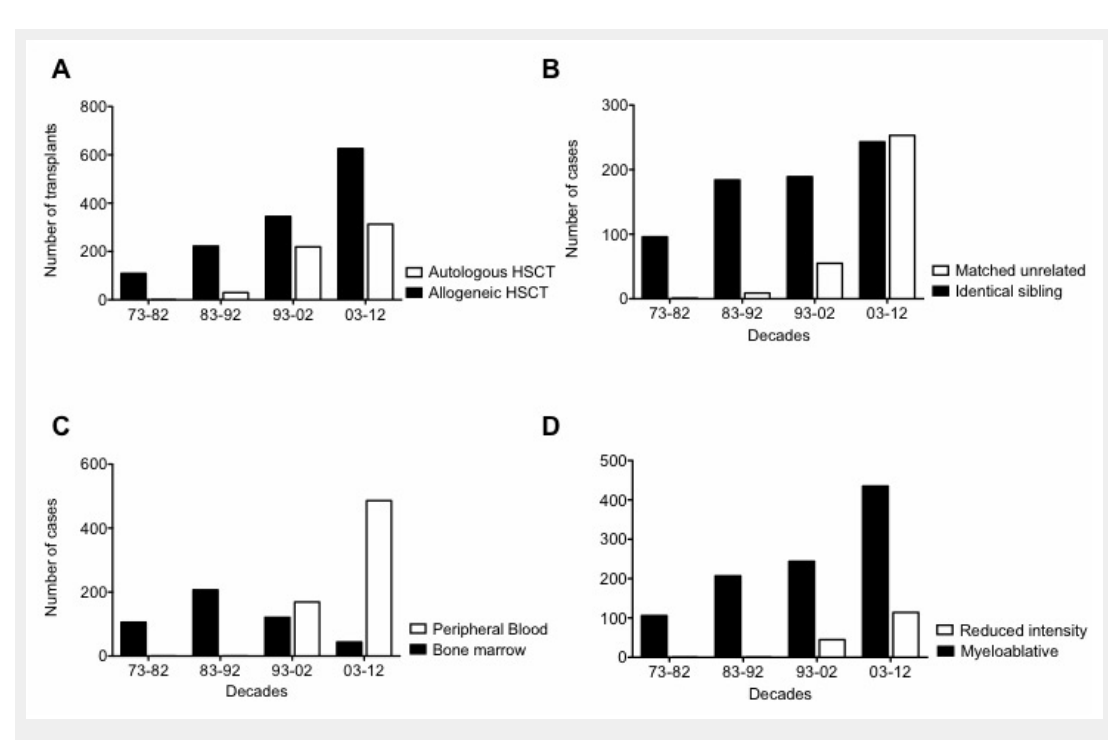
Figure 1 (A) Total allogeneic and autologous haematopoietic stem cell transplantation (HSCT) numbers over the decades. (B) Identical sibling and matched unrelated allogeneic HSCT patient case numbers over the decades. (C) Bone marrow and peripheral blood stem cell source patient case numbers in allogeneic HSCT. (D) Patient case numbers receiving myeloablative and reduced-intensity conditioning for allogeneic HSCT.